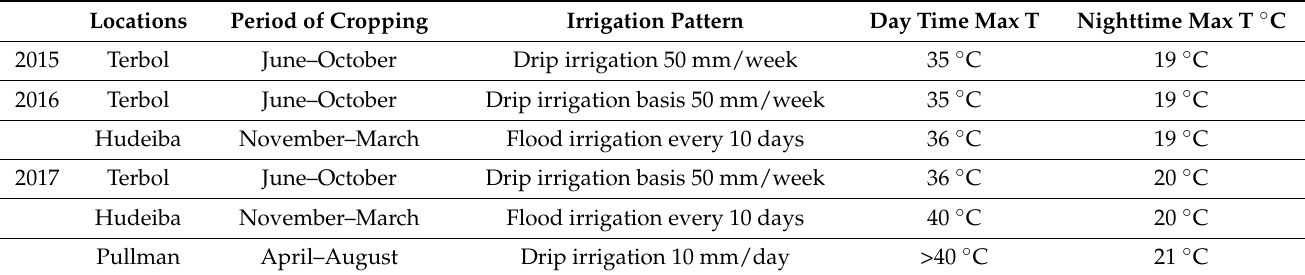
Table 9. Details of experiments conducted in different